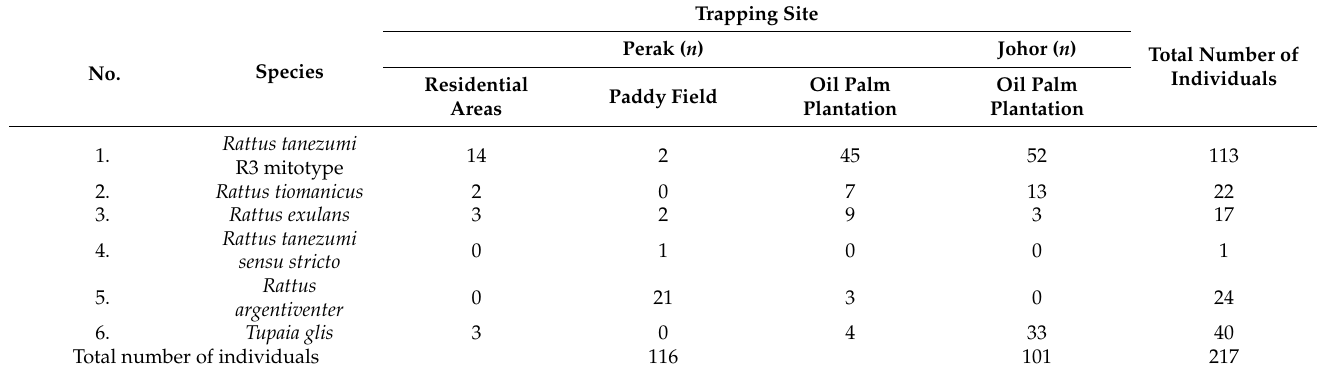
Table 2. The identification of small mammals trapped in Perak and